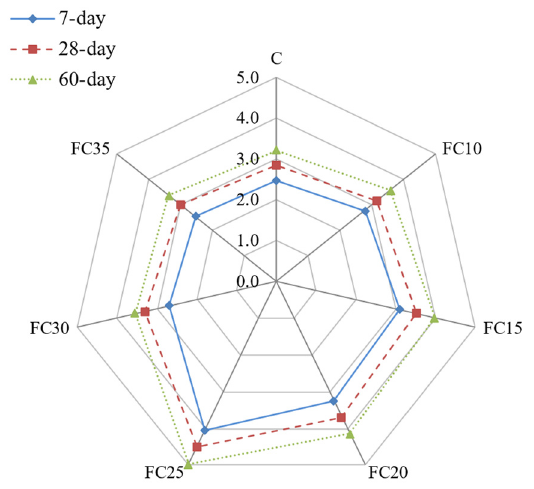
Figure 12. Influence of different weight fractions on performance index of LFC.